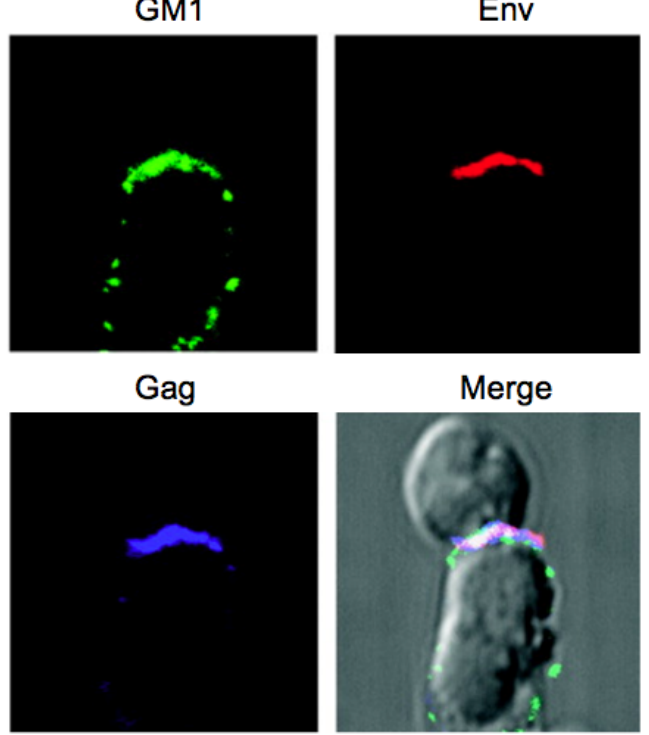
superimposed; white indicates the colocalization of three colors. Reprinted with